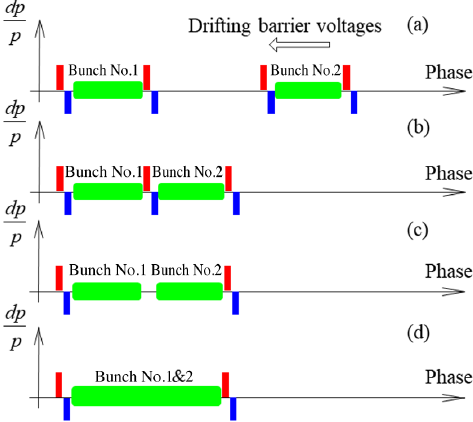
FIG. 1. Beam manipulation in the onDBB. Positive and negative voltages are in red and blue, respectively. (a) Bucket voltages confine bunches No. 1 and No. 2, and the right bucket moves towards the left. (b) Bunch No. 2 is adjacent to bunch No. 1. (c) The intermediate voltages are turned off to combine bunch No. 1 with bunch No. 2. (d) The long bunch is confinable with the new barrier